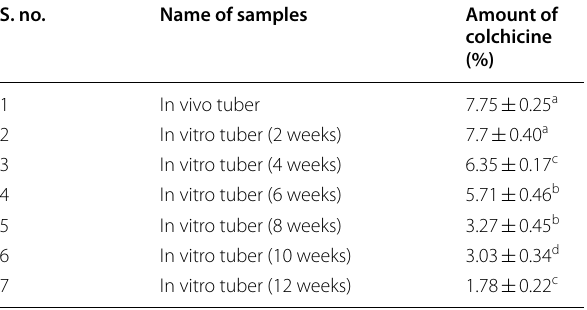
Column with same letters in superscript are not significant at P < 0.05 based on one-way analysis of variance followed by Duncan’s multiple range test [34]